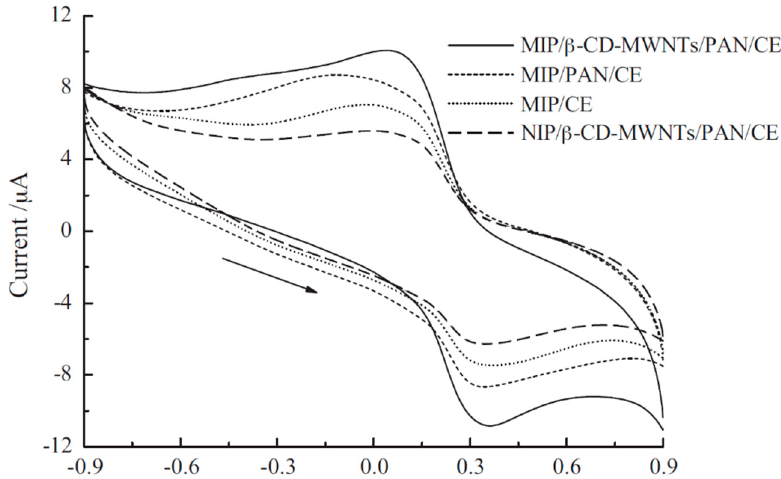
Figure 5. Voltammetric responses of the sensor in different stages of active surface modification immersed in 10 − 3 mol × L − 1 L-Phe in blood plasma samples. Reprinted from [61] with permission of publisher.